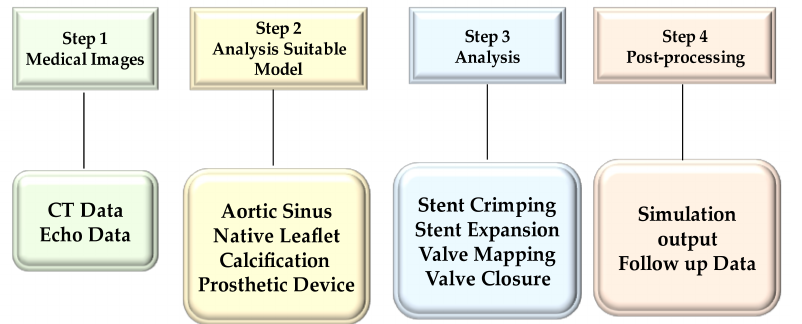
Figure 2. The computational framework aimed to simulate the implantation of TAVI. Four sections from Steps 1 to 4 of the worked-out modeling strategy are identified. The extrapolated images (ECHO and CT) allow biomodelling on which to perform the simulations to be established. The data obtained from the simulations are compared to the data that emerged in the follow-up. Abbreviations; CT; computed